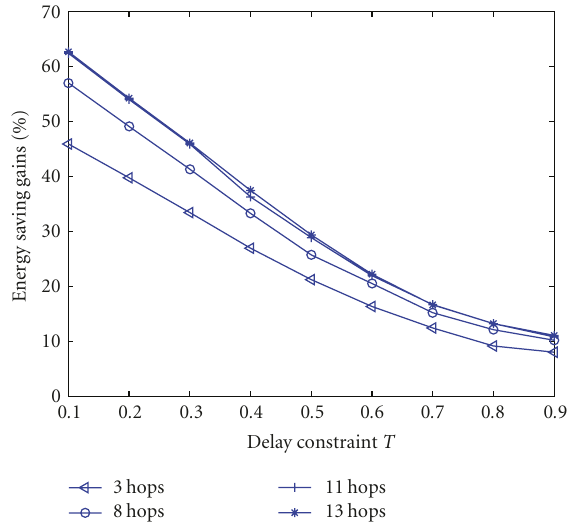
Figure 2: Energy savings for di ff erent number of hops under a tight delay constraint with target BER = 10 − 3